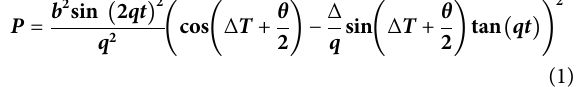
LIP Cs-3000 cesium atomic clock. The overall dimension of theLIP Cs-3000is435mm×133mm×500 mm.Itisthestandard dimension of the 3U case. Thus the LIP Cs-3000 could easily been installed on the standard 19 inch